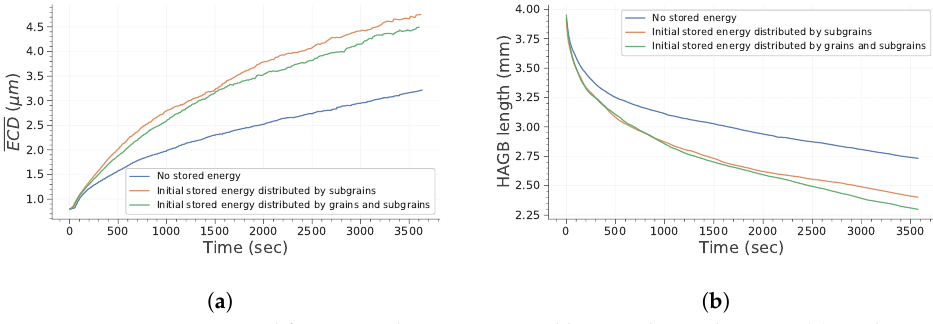
Figure 9. Main microstructural feature evolutions impacted by initial stored energy. ( a ) Evolution of ECD as a function of time. ( b ) HAGB total length as a function of time.